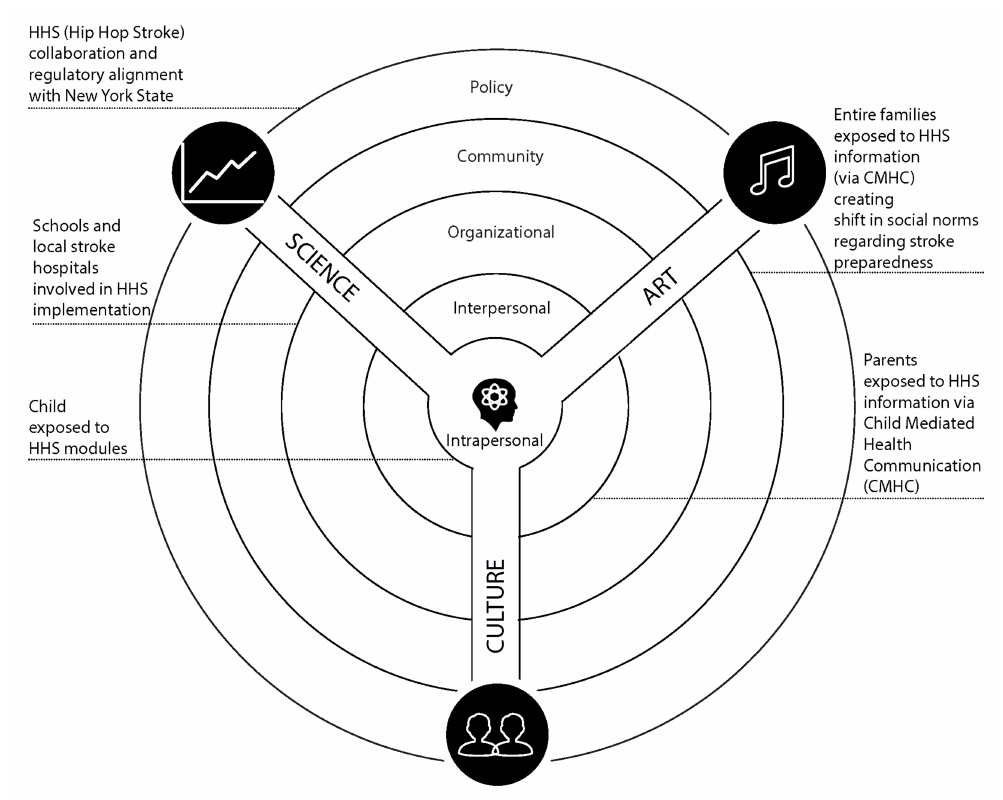
Figure 4. Hip Hop Stroke and the Socio-Ecological Model illustrated through the Multisensory Multilevel Health Education Model. Legend: CMHC = Child Mediated Health Communication; HHS = Hip Hop